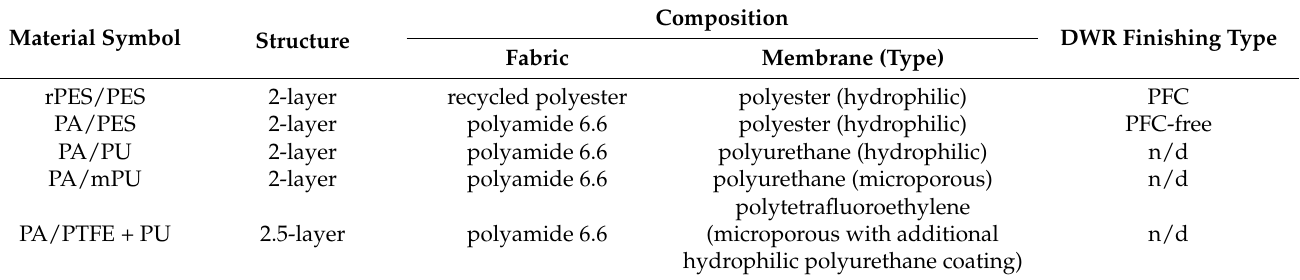
Table 1. Characteristics of laminated textile materials provided by producers.